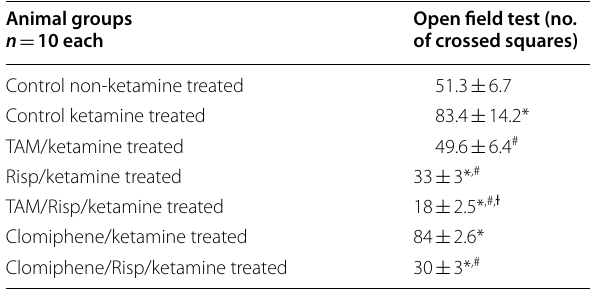
Table 1 Effects of test drugs on the number of crossed squares in the open field test in ketamine treated